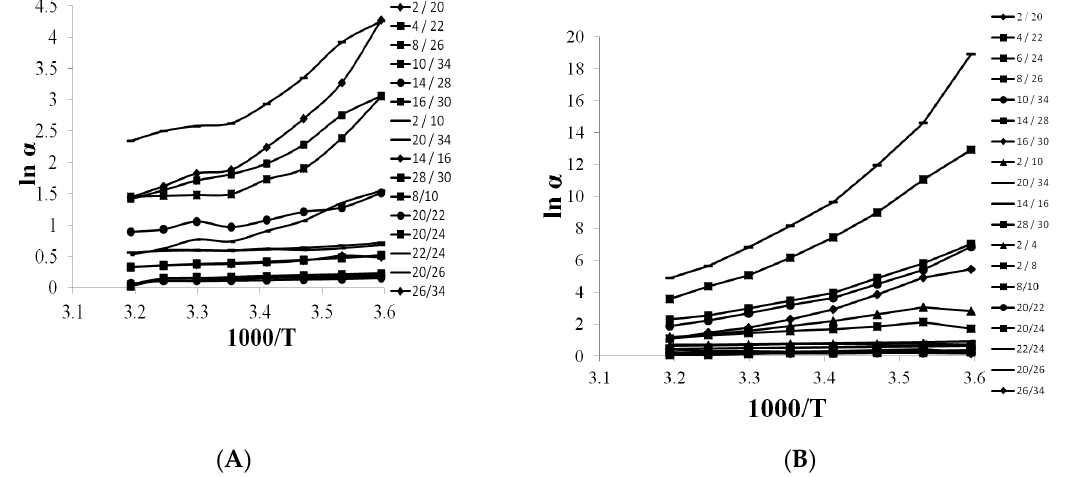
Figure 6. The selectivity plot for distinguishing pairs that differ with methylene or methyl moieties, heteroatoms, or isomeric form examined on Chirobiotic column by the use of 15% ACN ( A ) and 15% MeOH ( B ).